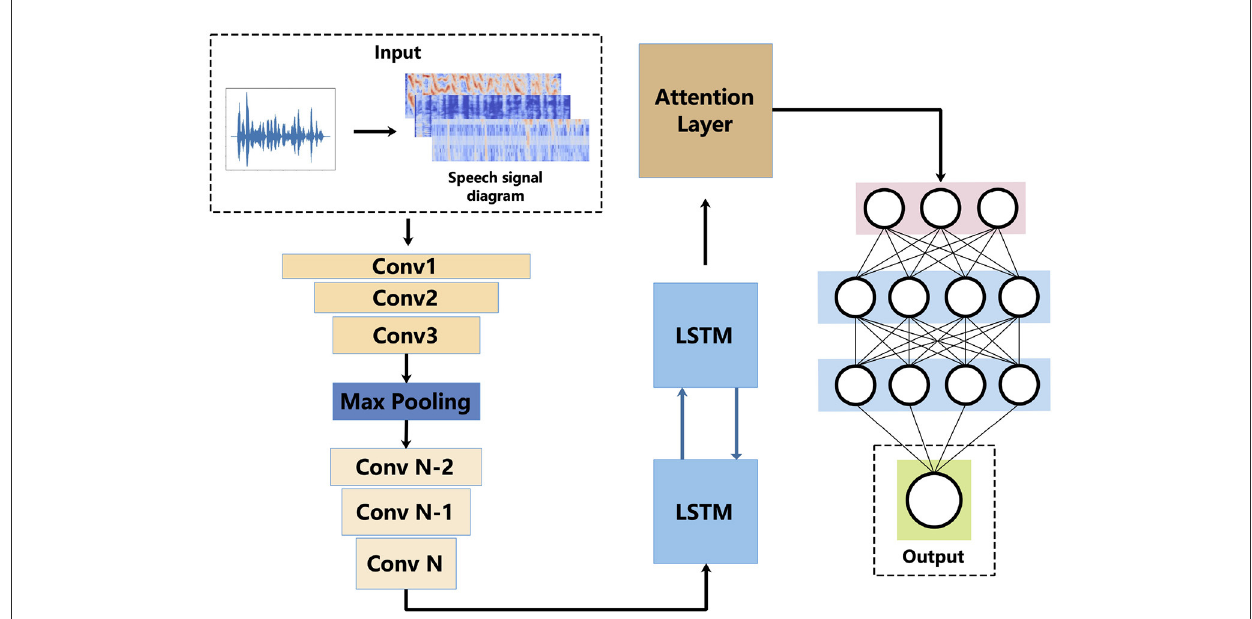
FIGURE1 Architecture of ResCNN-SER. This figure shows the work flow of the ResCNN SER model. Firstly, log-Mels spectra (static, delta and delta) is computed. The log-Mels spectral properties can be seen as a kind of image. On this basis, a convolutional neural network (CNN) is used for feature extraction. Using the LSTM model to extract features from time serious data. We use the attention-based mode to reinforce feature representation. A complete neural network to predict language